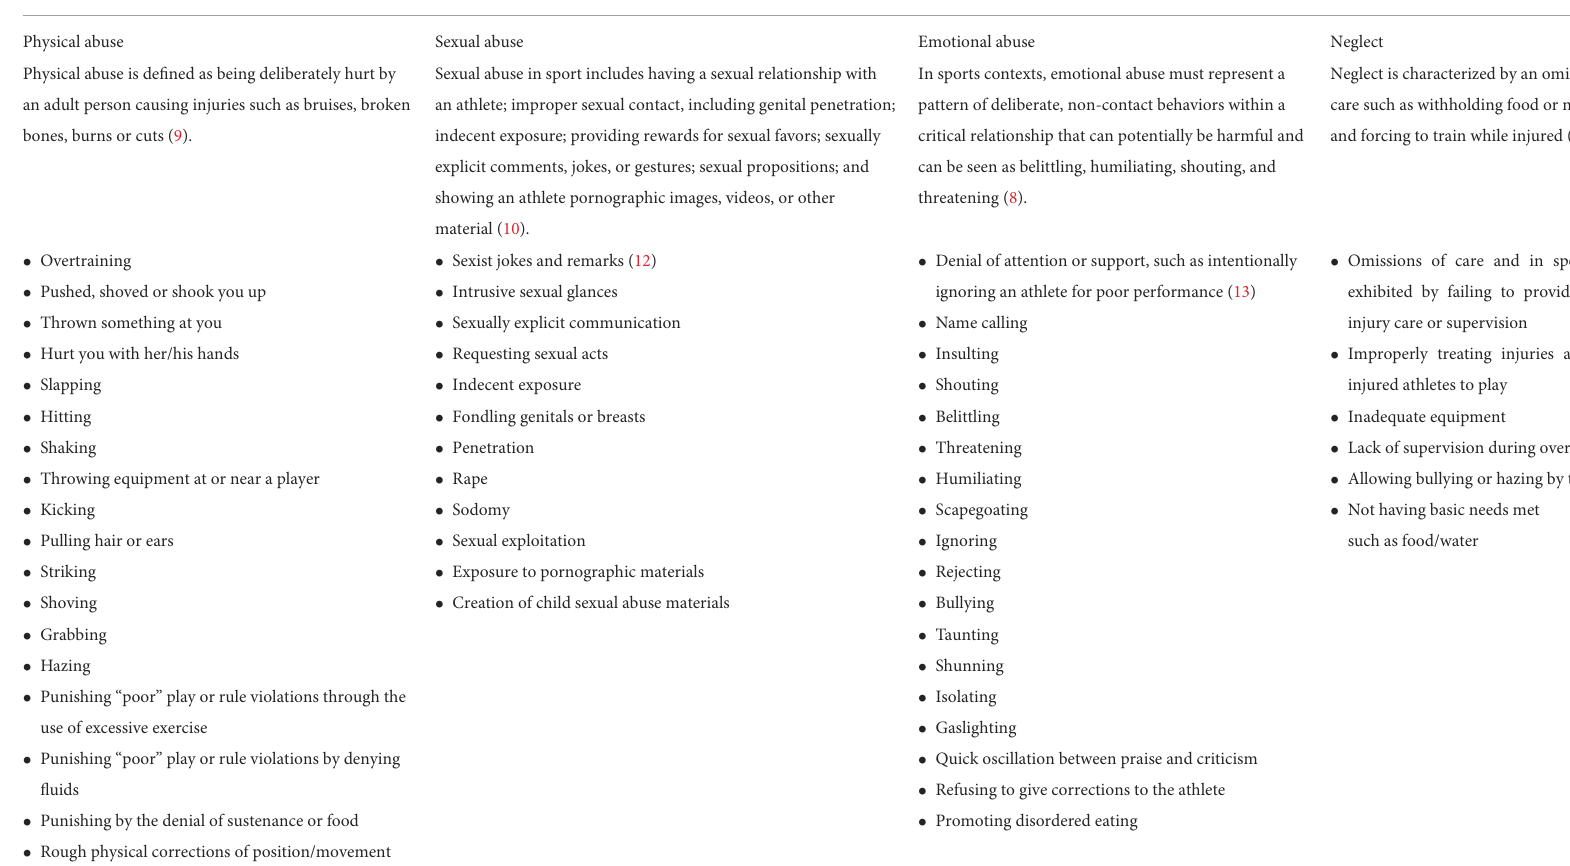
TABLE 1 Relational maltreatment.